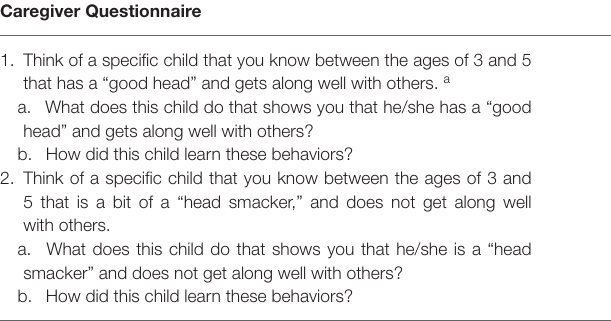
TABLE 2 | Caregiver open questionnaire.